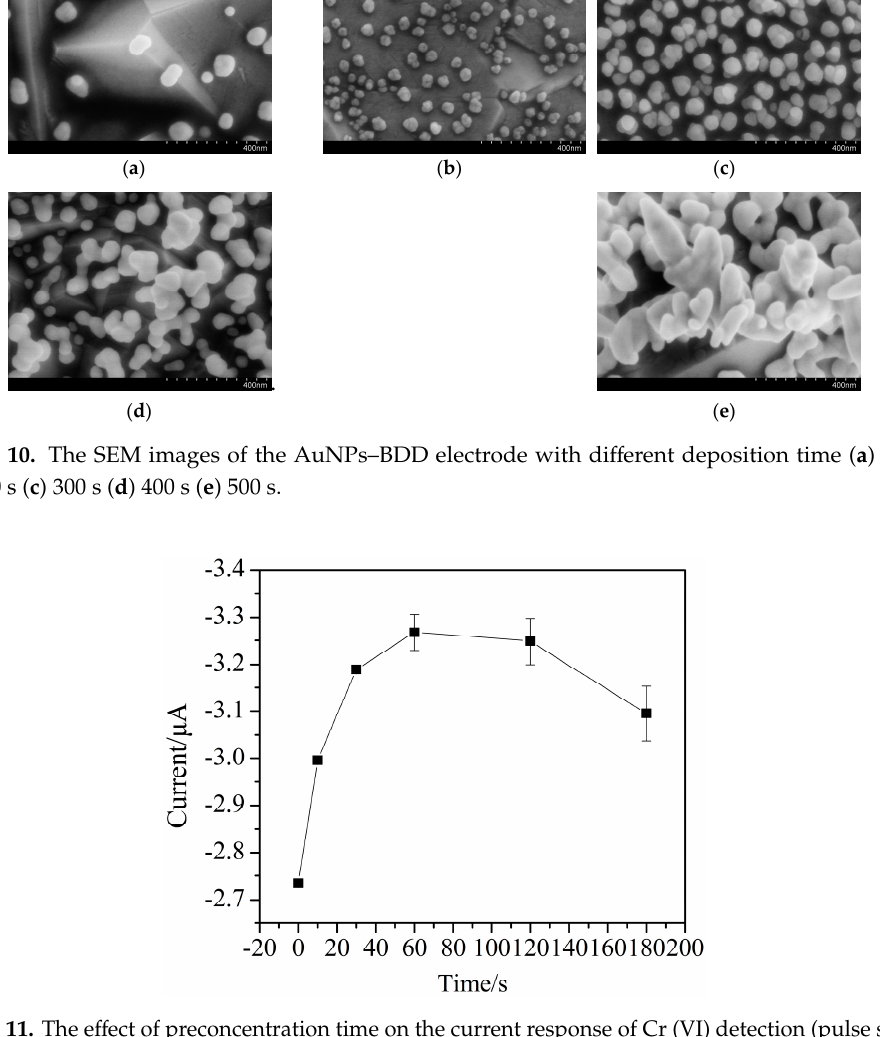
Figure 11 . The effect of preconcentration time on the current response of Cr (VI) detection (pulse size = 25 mV, frequency = 25 Hz, step size = 5 mV, 0.1 mol/L sodium acetate buffer, pH